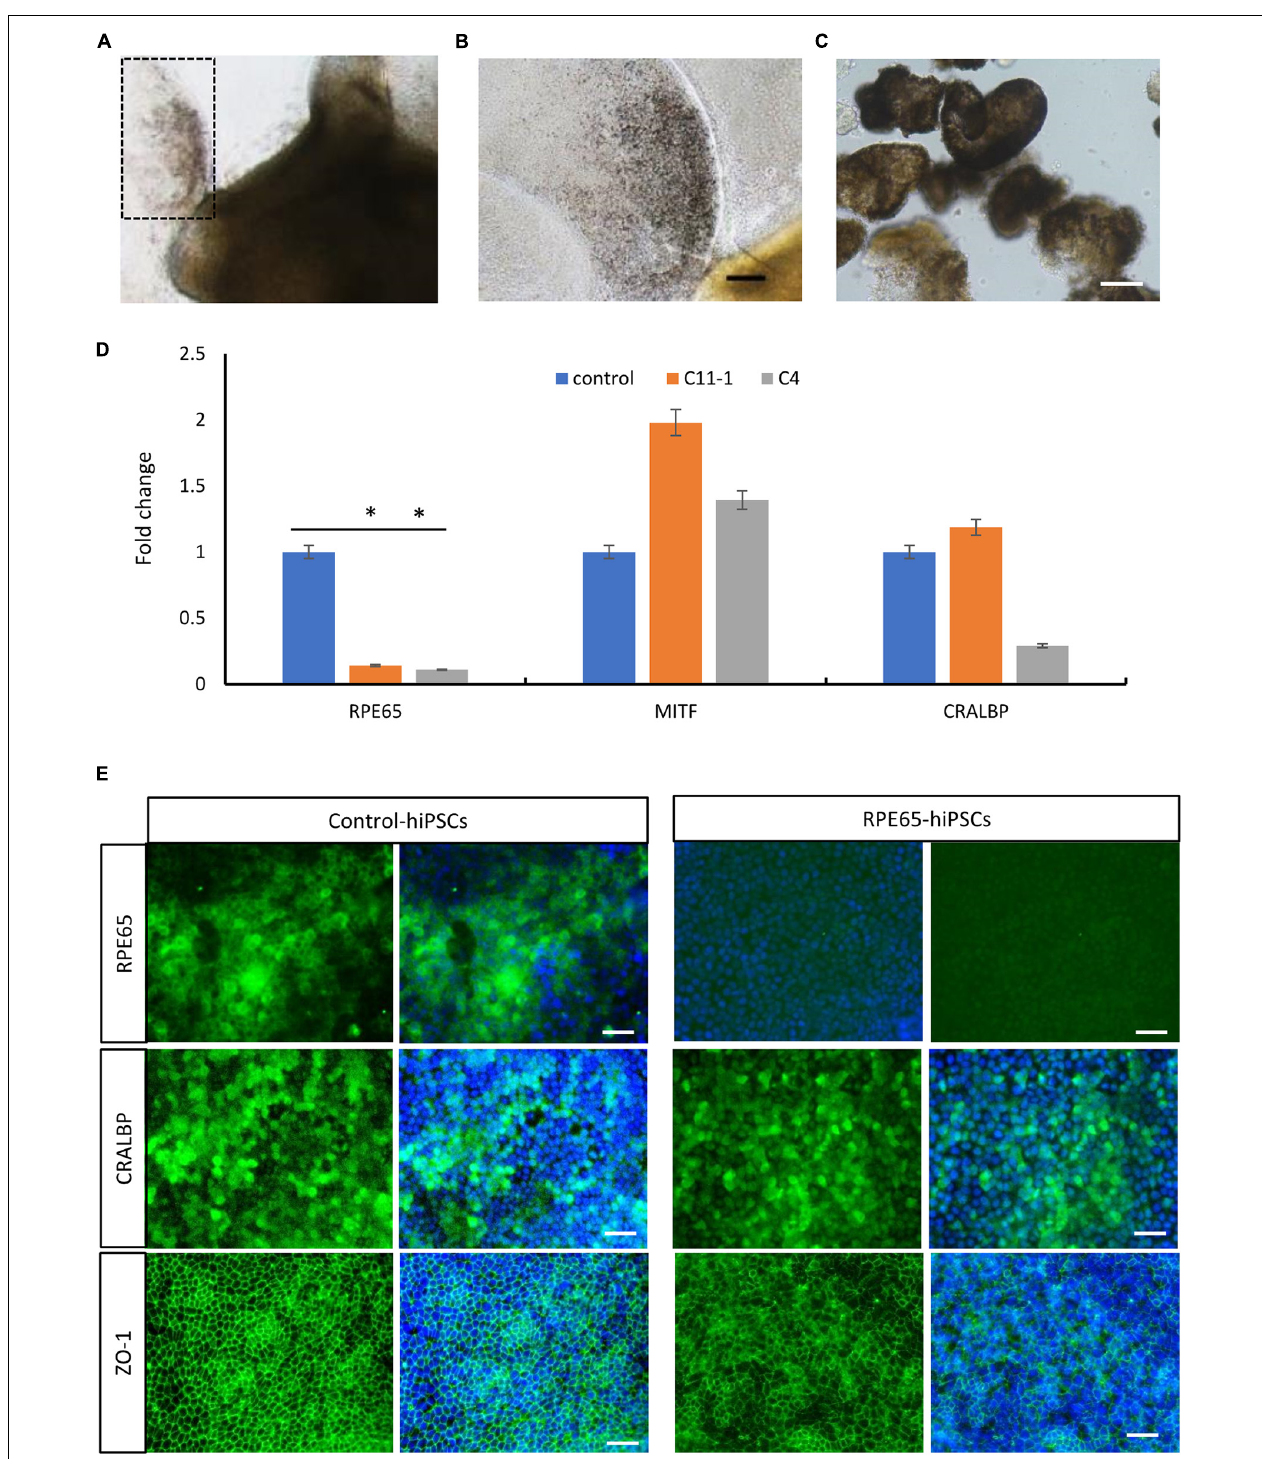
FIGURE 6 | Decreased expression of RPE65 in patient RPE cells. (A) Pigmented RPE cells (dashed area) differentiated from RPE65-hiPSCs. (B) Higher magnification of the dashed area in A . Scale bar, 100 µ m. (C) The picked RPE sheets on W8 after differentiation. Scale bar, 100 µ m. (D) qPCR analysis showed that the expression level of RPE65 was significantly lower in patient RPE cells (C11–1 and C4) than in the control (UE022), while MITF and CRALBP in patient RPE cells were comparable to the control. ∗ P < 0.05. Data presented as mean ± SD , n = 3. (E) Immunofluorescence staining revealed that RPE65 were negative in RPE65-hiPSCs derived RPE cells, but positive in control hiPSCs derived RPE cells, while both CRALBP and ZO-1 were strongly positive in patient and control RPE cells. Scale bars, 20 µ m.